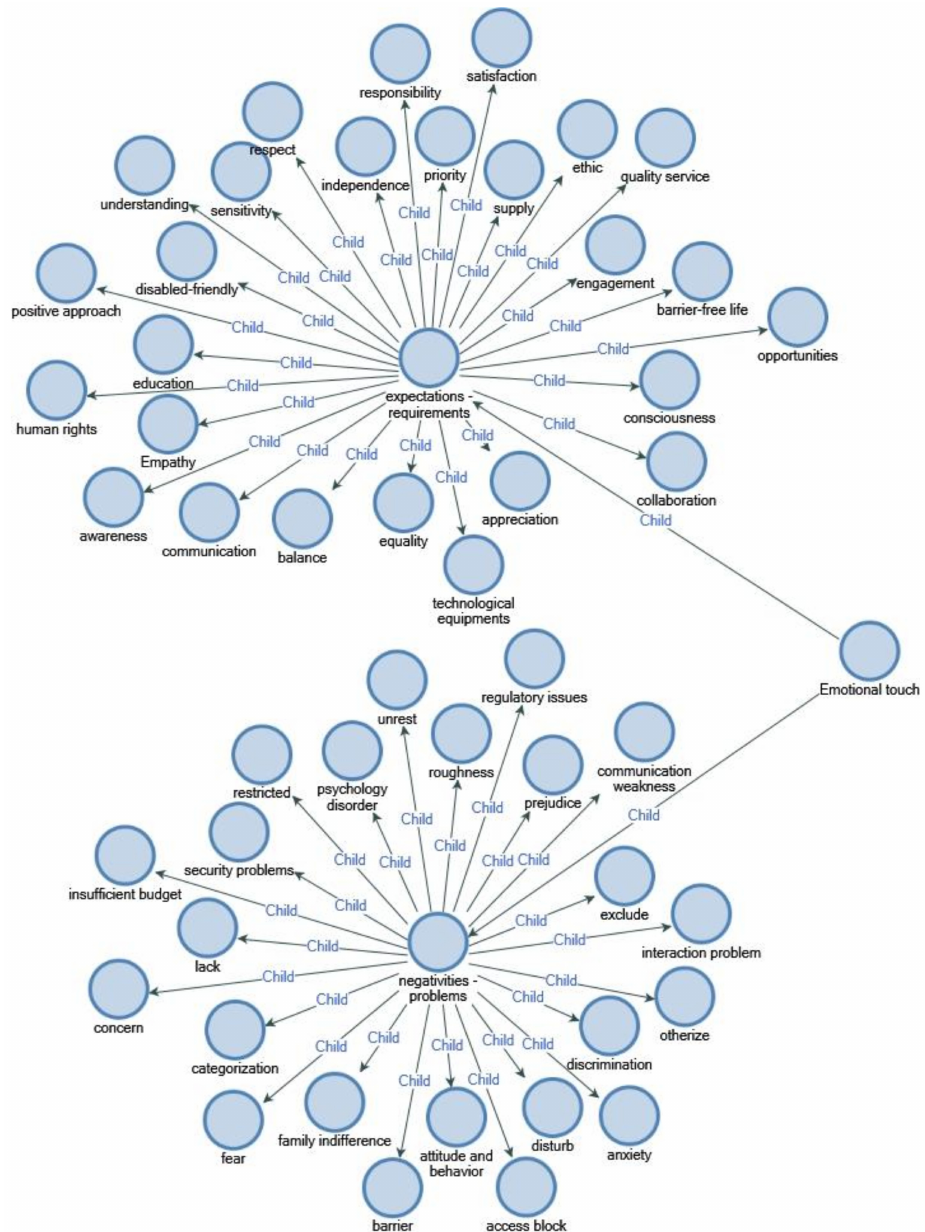
Figure 7. Emotional